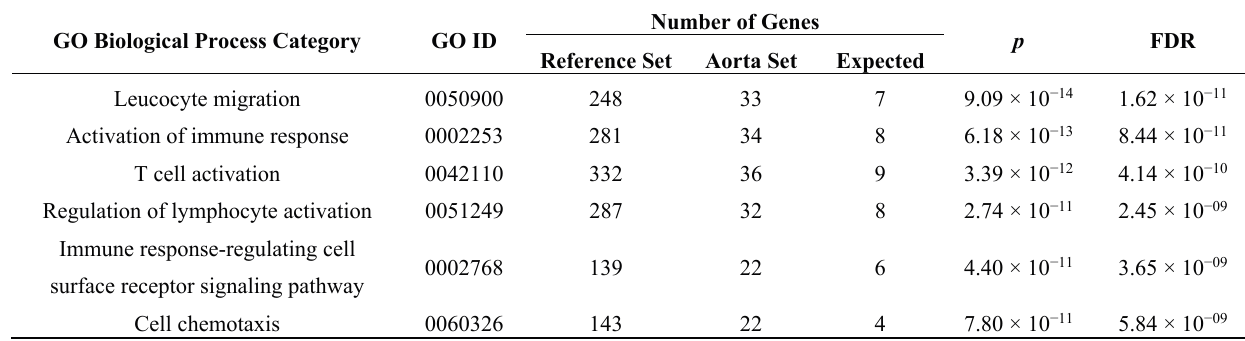
Table 7. Enriched GO biological process categories for the up-regulated target genes identified in AAA ChIP-chip with transcription factors RUNX1, ELF1, ETS2 and STAT5.